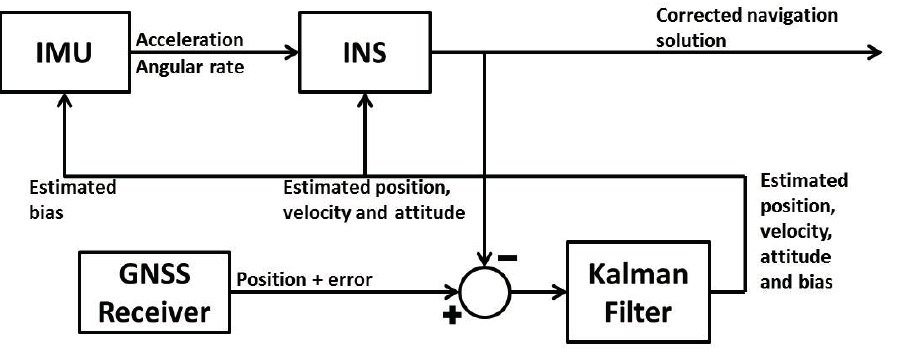
Figure 2. The architecture of the integration system with Extended Kalman Filter